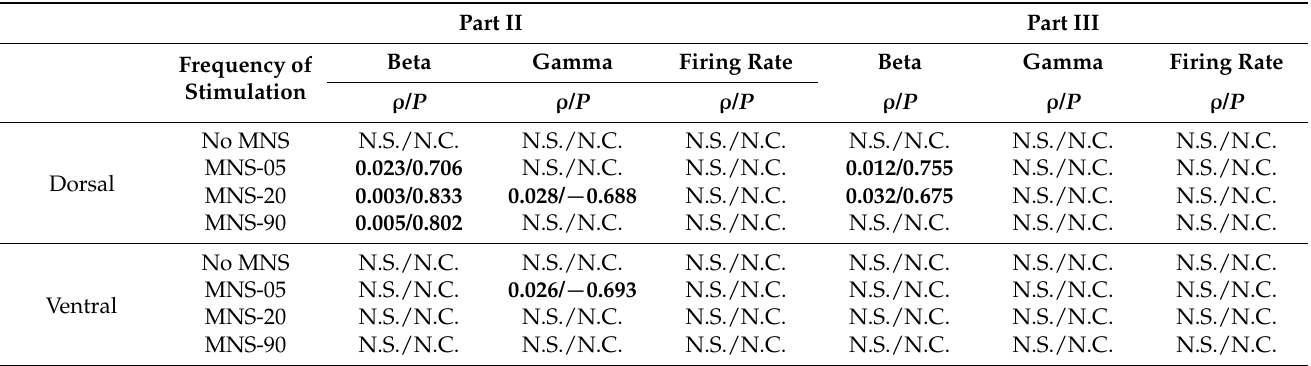
Table 4. Spearman’s correlation between power bands, with beta and gamma and motor clinical outcomes from